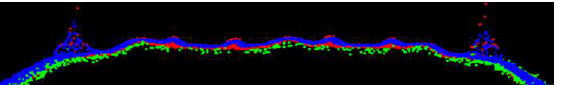
Figure 13: cross section on railroad. Red=VQ480, Green=Puck, Blue=Photogrammetry.